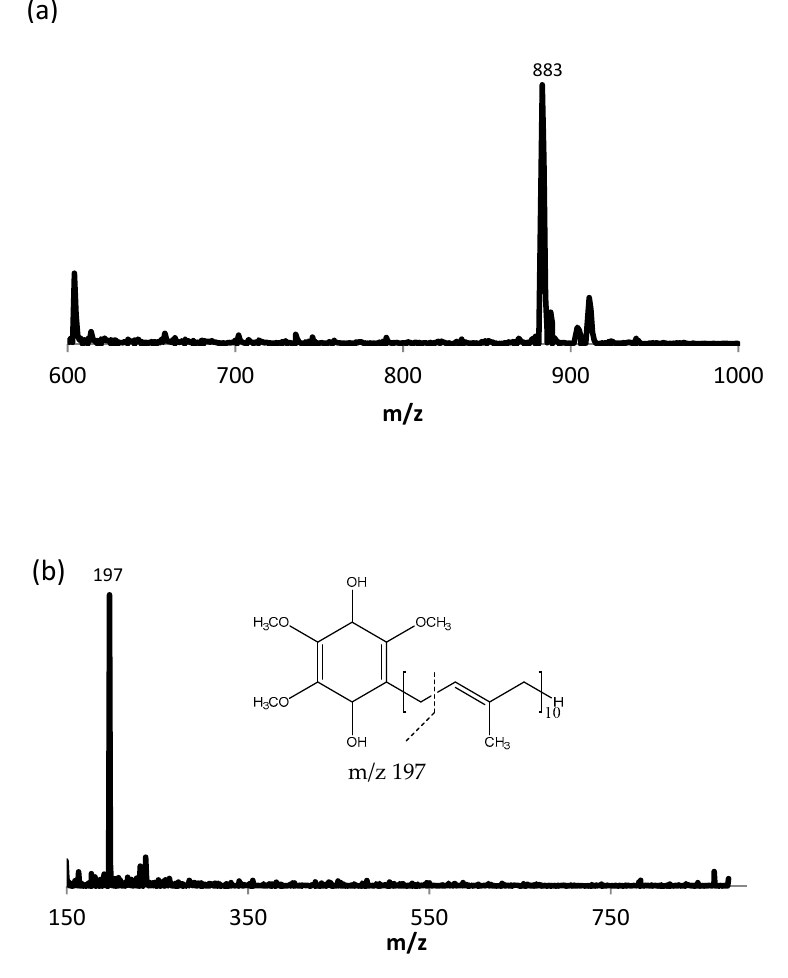
Figure 3. ( a ) Full scan mass spectrum of CoQ 10 H 2 , [M + NH 4 ] + . ( b ) Product ion mass spectrum of CoQ 10 H 2 ( m / z of 197) .